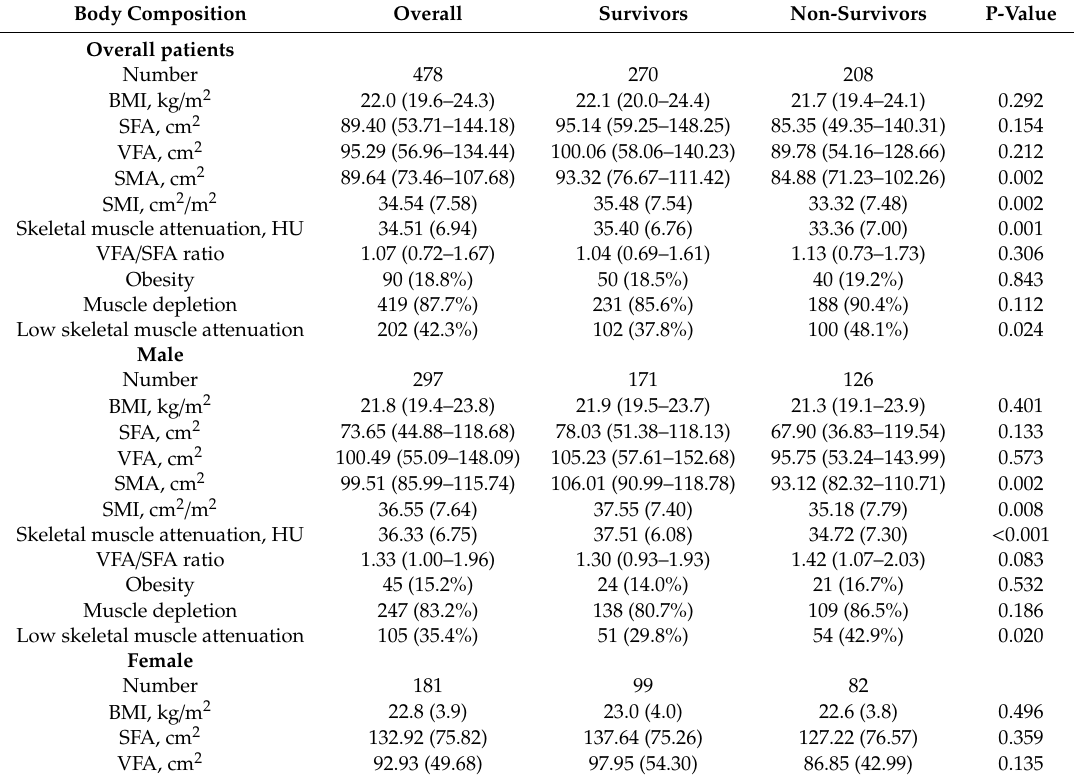
Table 2. Body composition of study patients by sex and 90-day